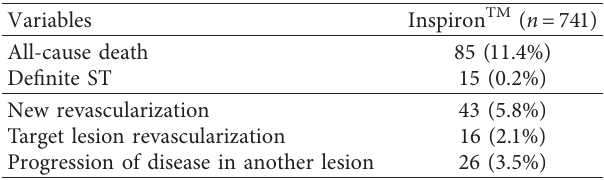
Table 3: Major adverse cardiac events in twelve